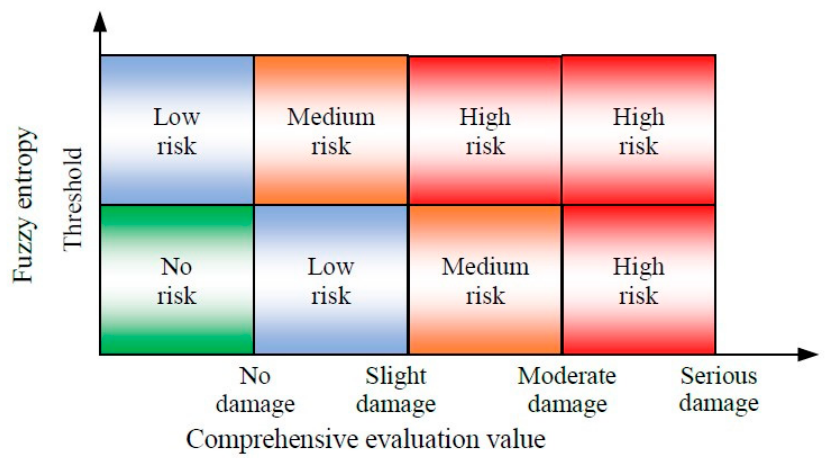
Figure 12. Risk assessment process of tunnel failure in the Ashele copper mine.